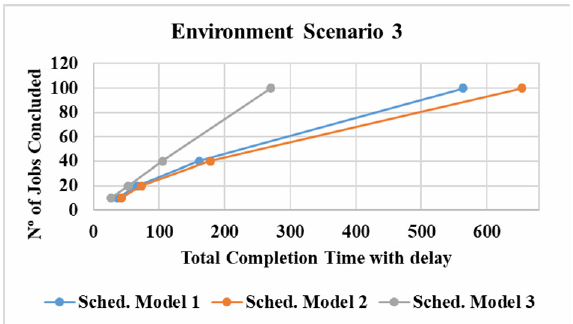
Figure 6. Simulation results of 3 Scheduling Models over the environment scenarios (variation of amplitude 100%)